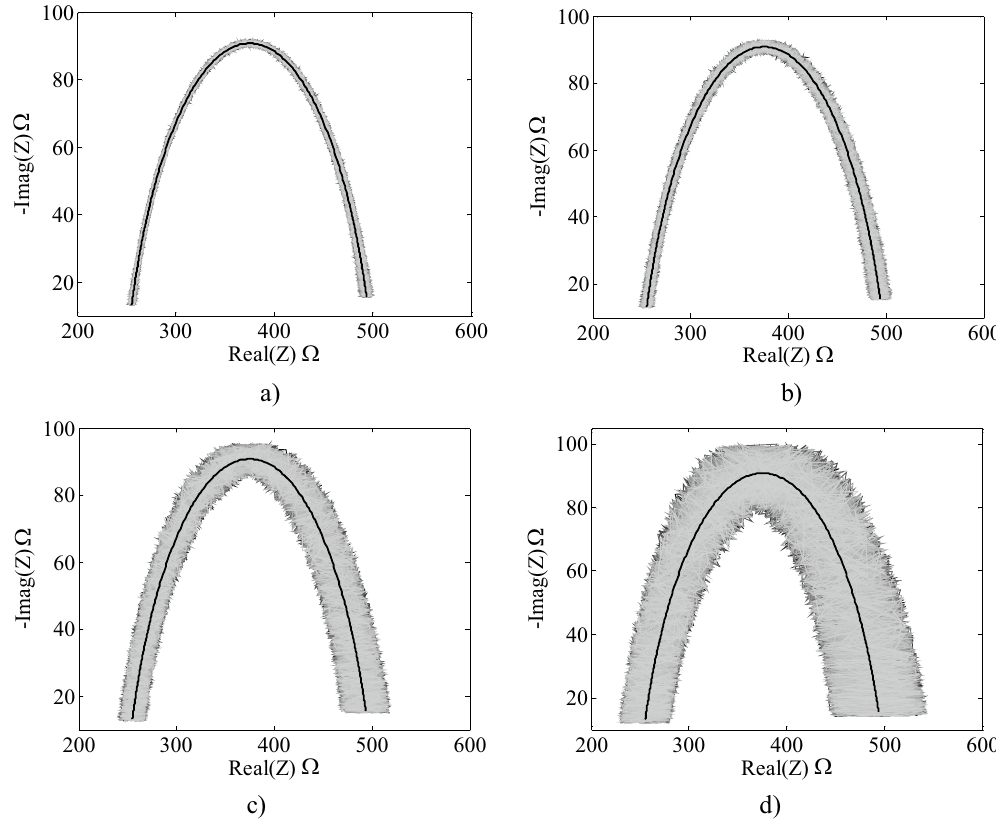
Figure 3. Complex representation of the noisy spectra at different noise levels, ( a ) 1%, ( b ) 2%, ( c ) 5%, ( d ) 10%. The middle solid lines in black represent the spectrum without noise.